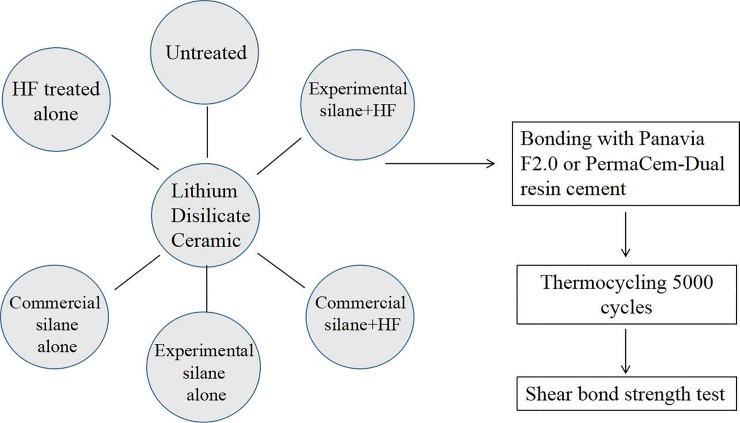
The schematic test protocol.